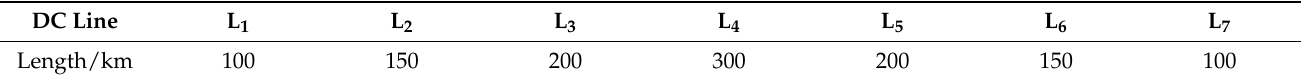
Table 3. Parameters of DC lines.